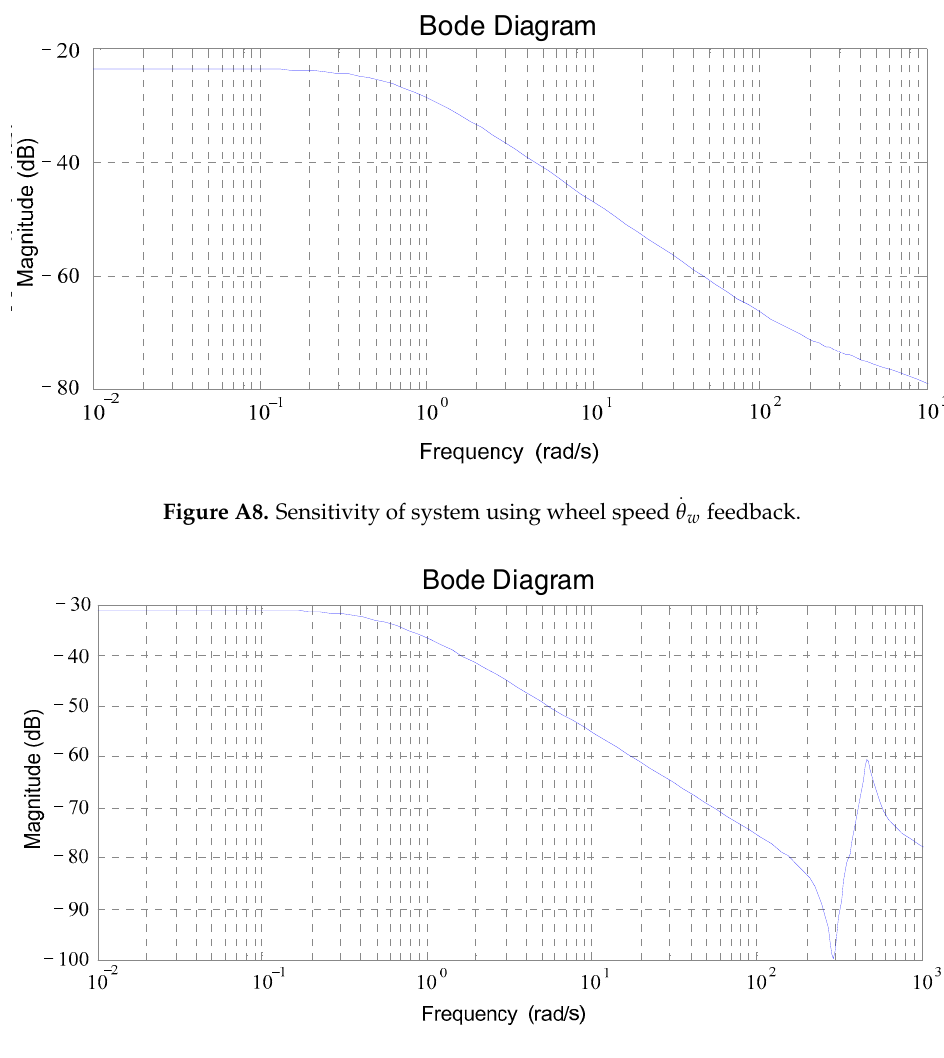
Figure A9. Sensitivity of system using transmission torque τ feedback.